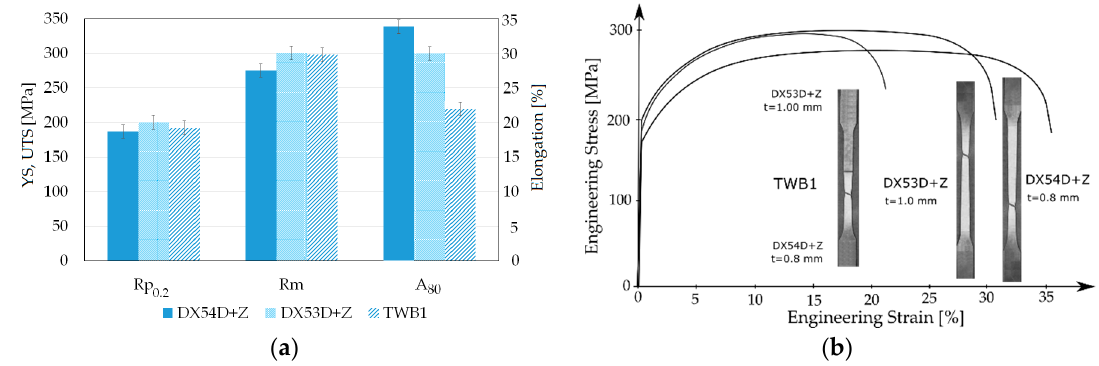
Figure 8. ( a ) The yield stress, tensile strength, and elongation of the base materials and TWB1; ( b ) the stress–strain curves of the base materials and TWB1.